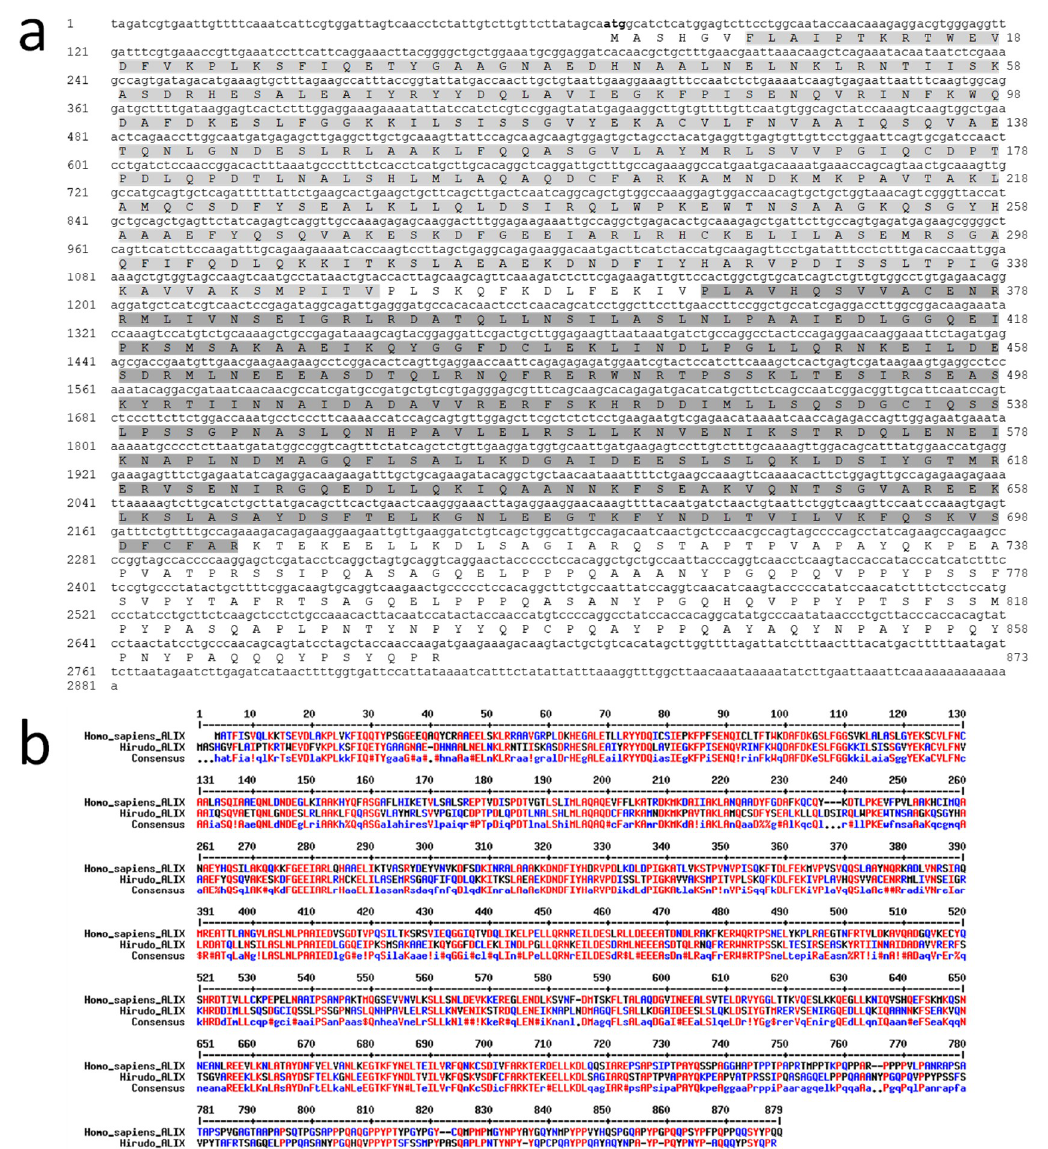
Figure 2. Molecular characterization of Hirudo medicinalis ( Hm ) Alix. ( a ) Hm Alix is a protein of 873 amino acids (~97 kDa) from a mRNA of 2281 nucleotides. Hm Alix protein is composed of N-terminal Bro1 (IPR038499, light grey) and Alix V-shaped (IPR025304, dark grey) domains, as observed in counterparts from other organisms. ( b ) The sequence alignment between Hm Alix and Homo sapiens Alix forms shows high and low consensus homologies (red and blue residues, respectively) which allows using polyclonal anti-human Alix antibodies to detect the protein in the leech central nervous system (CNS).